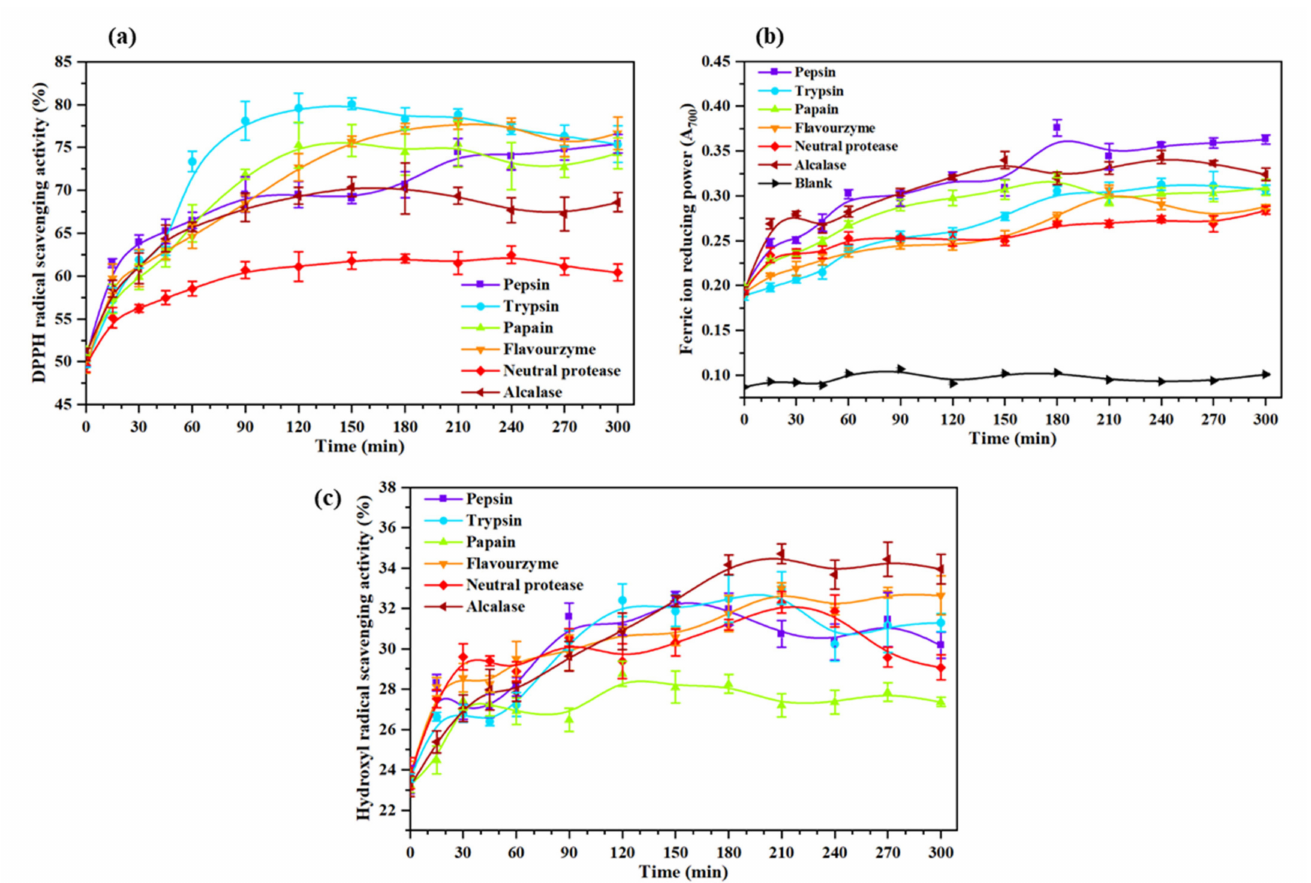
Figure 3. Antioxidant activity of hydrolysates of the Oviductus Ranae protein. All data were measured three times in parallel, and all experimental data were expressed in the form of mean ± standard deviation (SD). ( a ) DPPH radical scavenging activity of Oviductus Ranae protein and its enzymatic hydrolysates. ( b ) Reducing power of Oviductus Ranae protein and its enzymatic hydrolysates. ( c ) Hydroxyl radical scavenging activity of Oviductus Ranae protein and its enzymatic